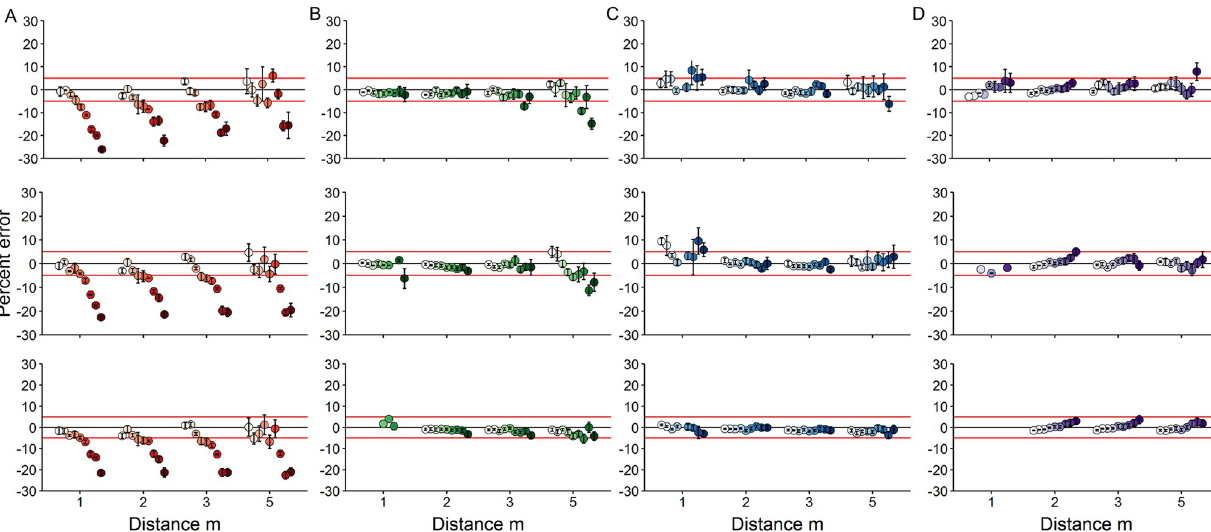
Fig 3. Pool experiment length estimate error plots. Mean percent error ( ± 95% CIs) in red snapper fork length estimates with increasing distance (m) and angle of incidence (AOI, degrees) as measured with the A) RLS (75 mm baseline, red gradient), or SCs at baseline distances of B) 406 mm (BD1, green gradient), C) 610 mm (BD2, blue gradient), or D) 762 mm (BD3, purple gradient) in the pool experiment. Filled circles (n = 9) from left to right in each panel indicate AOIs from 0 to 40˚ at 5˚ increments. Horizontal red lines indicate the ± 5% error thresholds. Top, middle, and bottom rows in each column indicate measurements for small (288 mm FL), medium (552 mm FL), or large (890 mm FL) paper red snapper models, respectively. Distance and AOIs with length errors below 5% were deemed viable for collecting fish length measurements from ROV survey videos in the field experiment.